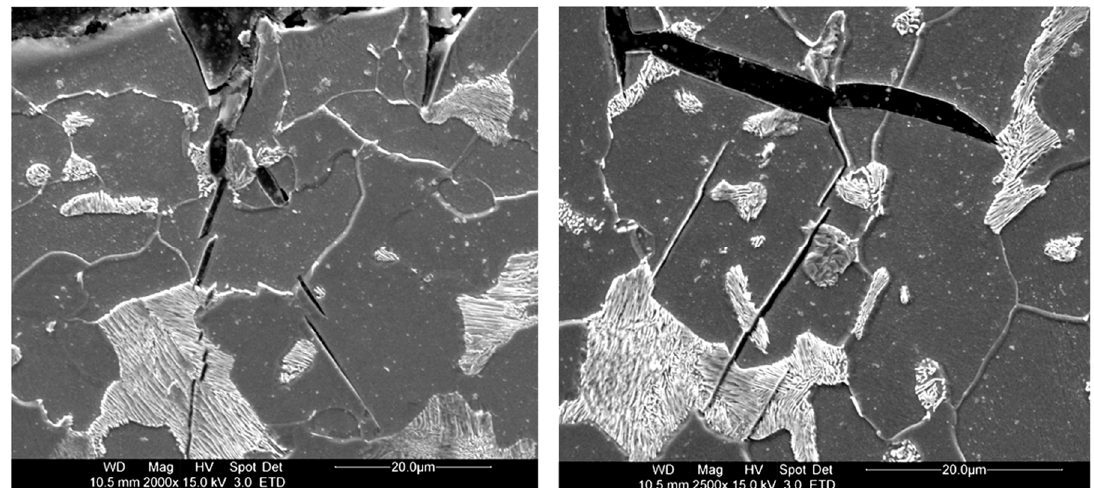
Figure 8. Examples of crack ends branching.